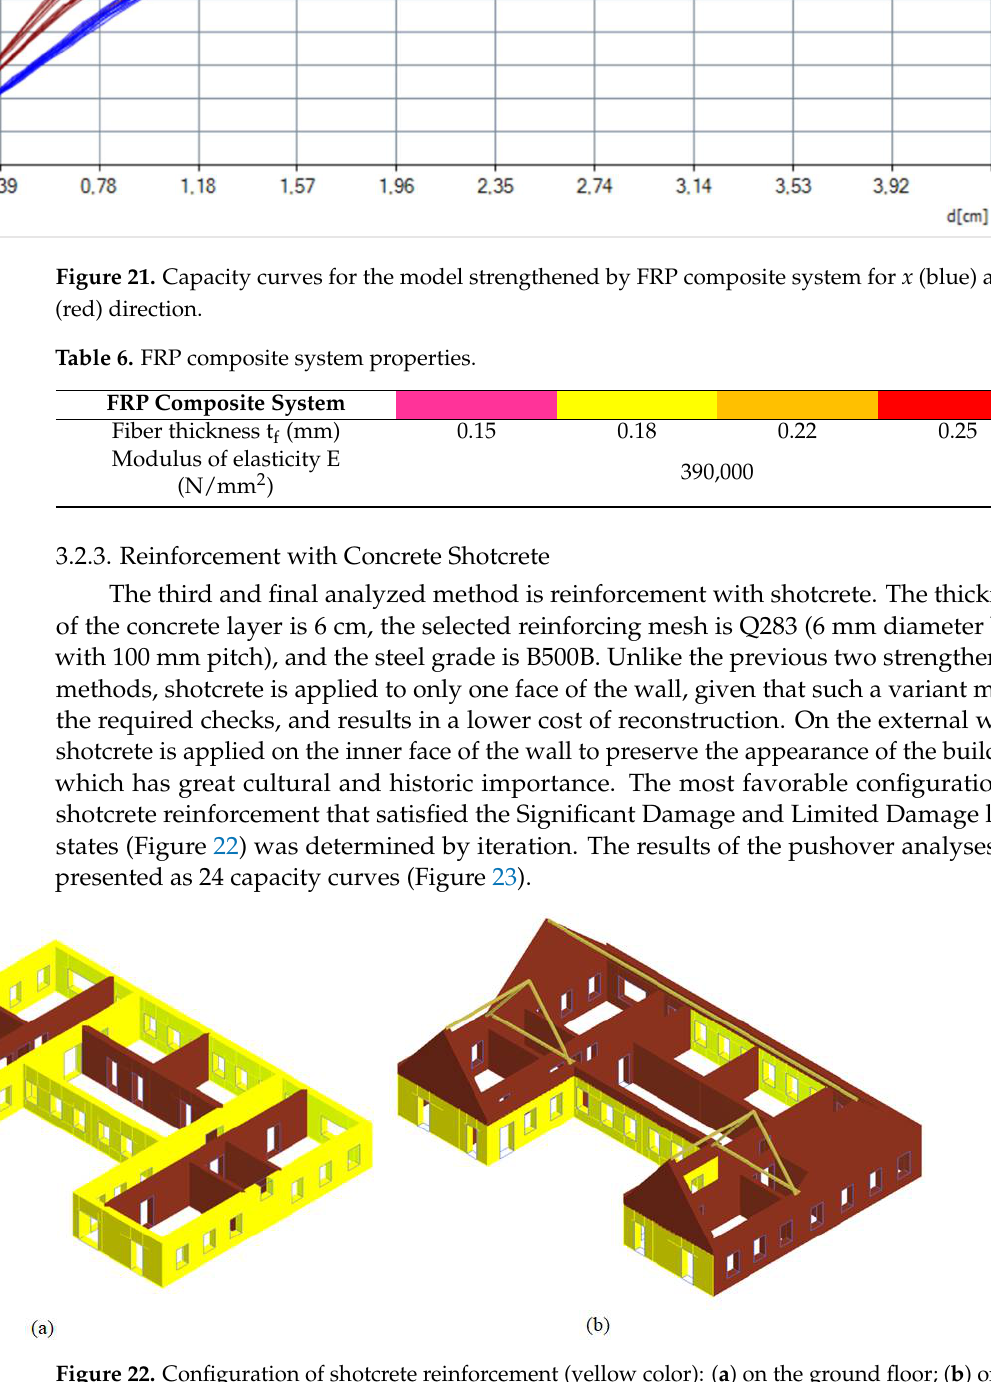
Figure 23. Capacity curves for the model strengthened by shotcrete for the x (blue) and y (red) di- rection. 3.3. Comparison of Strengthening Methods The risk indices of the most significant pushover analysis for both Significant Dam- age and Damage Limitation limit state are presented in Table 7. The limit state is consid- ered satisfied if the vulnerability index α is greater than 1.00. The vulnerability index α is the result of the pushover analysis and is defined as the ratio between the limit capacity acceleration of the building and the reference peak ground acceleration. Two vulnerability indices are calculated for every pushover analysis: one for Significant Damage LS and one for Damage Limitation LS. The limit capacity acceleration of the building is the peak ground acceleration for which the structure reaches one of the two limit states. For Limit State of Significant Damage, the return period of PGA is 475 years, corresponding to the probability of exceedance of 10% in 50 years. For Limit State of Damage Limitation, the return period of PGA is 95 years, corresponding to the probability of exceedance of 10% in 10 years. The PGA values are input data for seismic load. The value of the vulnerability index for each of the two limit states must be greater than 1.00. The EN 1998-3 defines the Significant Damage Limit State as follows: the structure is significantly damaged, with some residual lateral strength and stiffness, and vertical elements can sustain vertical loads. Non-structural components are damaged, although partitions and infills have not failed out-of-plane. The structure can sustain after-shocks of moderate intensity. The Damage Limitation Limit State can be defined as follows: the structure is only lightly dam- aged, with structural elements prevented from significant yielding, and retaining their strength and stiffness properties. Non-structural components, such as partitions and